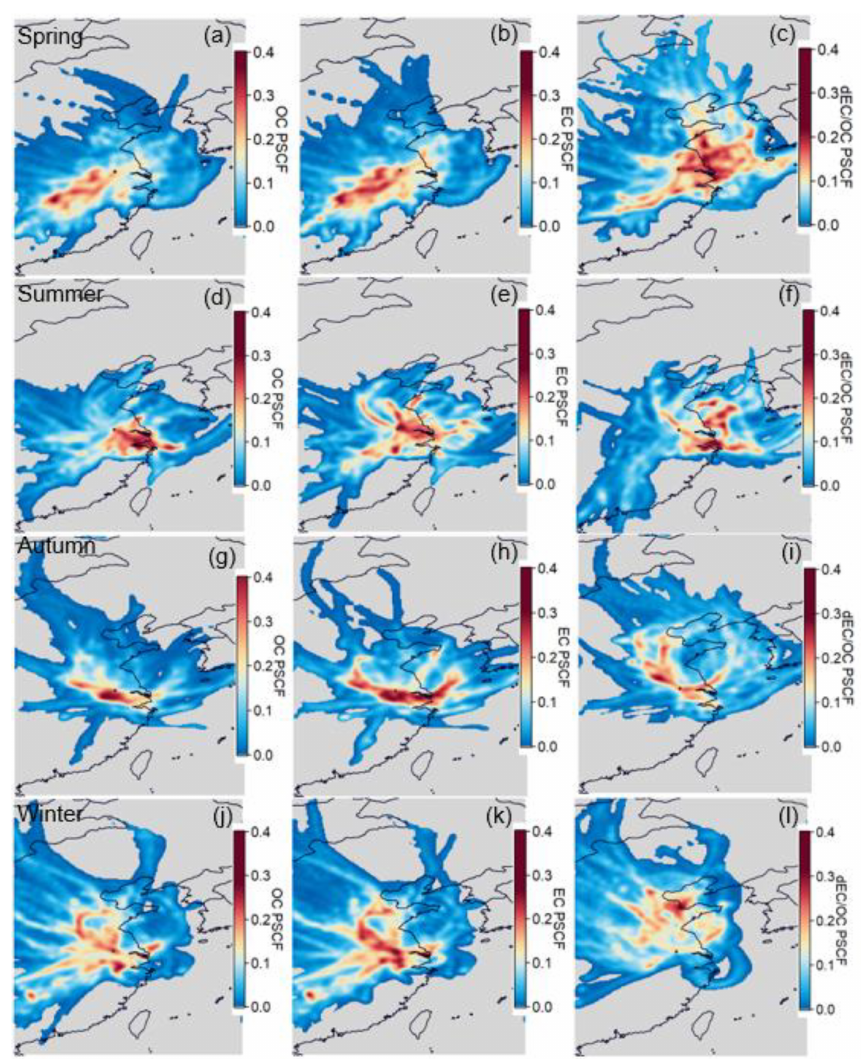
Figure 9. PSCF map for OC, EC and dEC / OC in spring (a–c) , summer (d–f) , autumn (g–i) and winter (j–l)